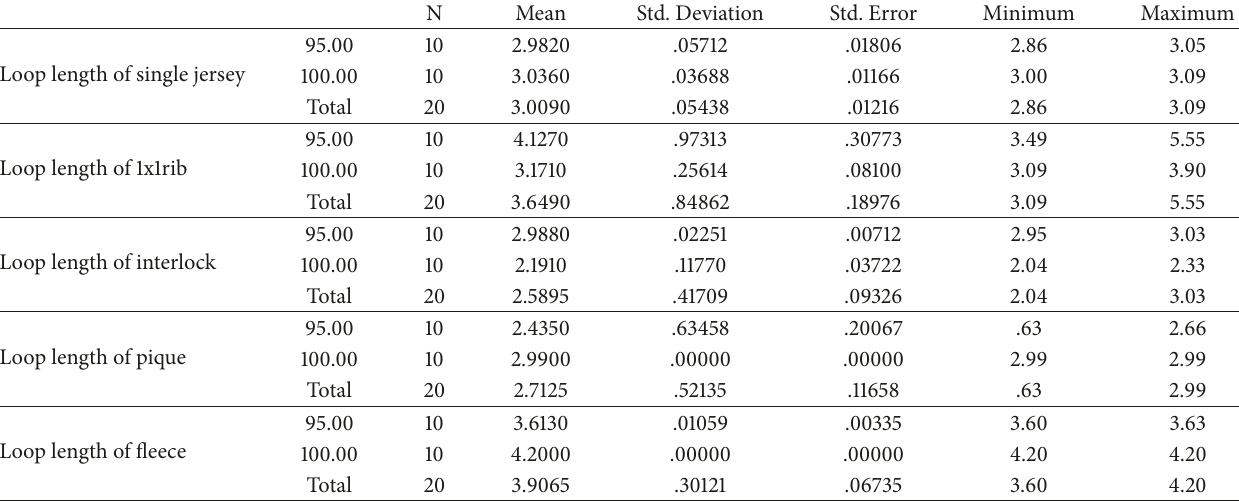
Table 1: Description for loop lengths of knitted fabrics made from 100% cotton and cotton/elastane yarns. N Mean Std. Deviation Std. Error